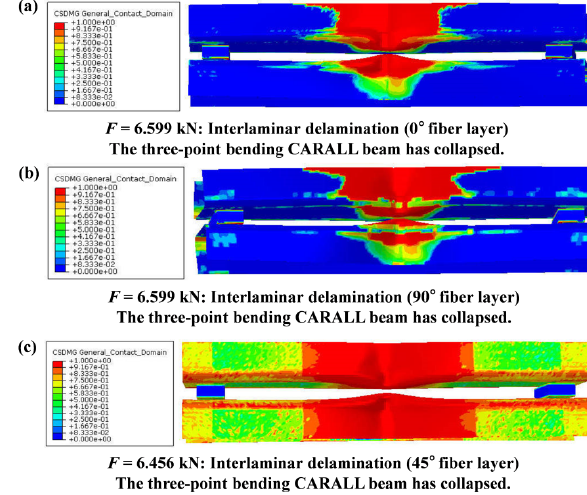
Figure 14: Delamination failure area distribution of double-channel CARALL beams at final failure state: (a) SHCXL-A: 0 ∘ fiber layer; (b) SHCXL-A: 90 ∘ fiber layer; and (c) SHCXL-B: 45 ∘ fiber